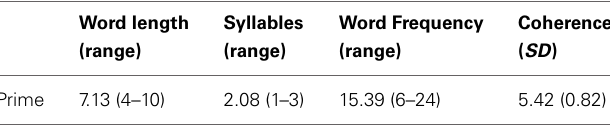
Table 3 | Summary of results from pre-tests for selected primes for Experiment